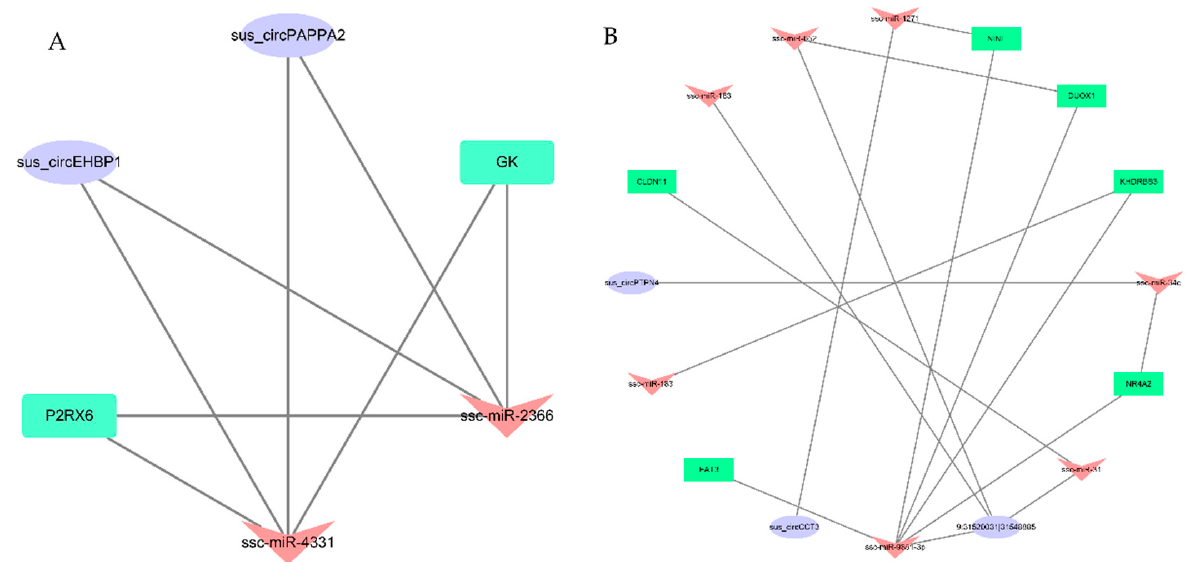
Figure 5. CeRNA network construction. ( A ) CircRNA–miRNA–mRNA interaction network according to the different expression data in backfat tissue between castrated pigs and intact male pigs. The network consists of two circRNAs, two miRNAs and two mRNAs. ( B ) CircRNA–miRNA–mRNA interaction network according to the different expression data in abdominal fat tissue between castrated pigs and intact male pigs. The network consists of three circRNAs, seven miRNAs and six mRNAs. The oval represents circRNAs, the V shapes represent miRNAs and the rectangle represents genes.